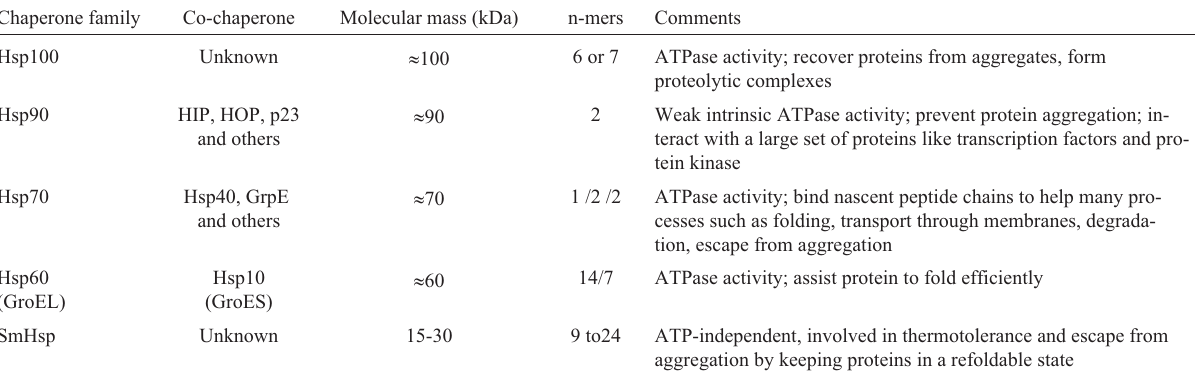
Table 1 - Molecular chaperones classification. Chaperone family